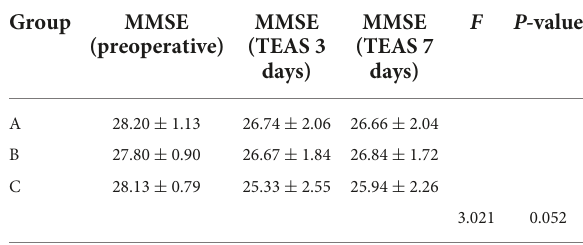
TABLE 2 MMSE scores in three